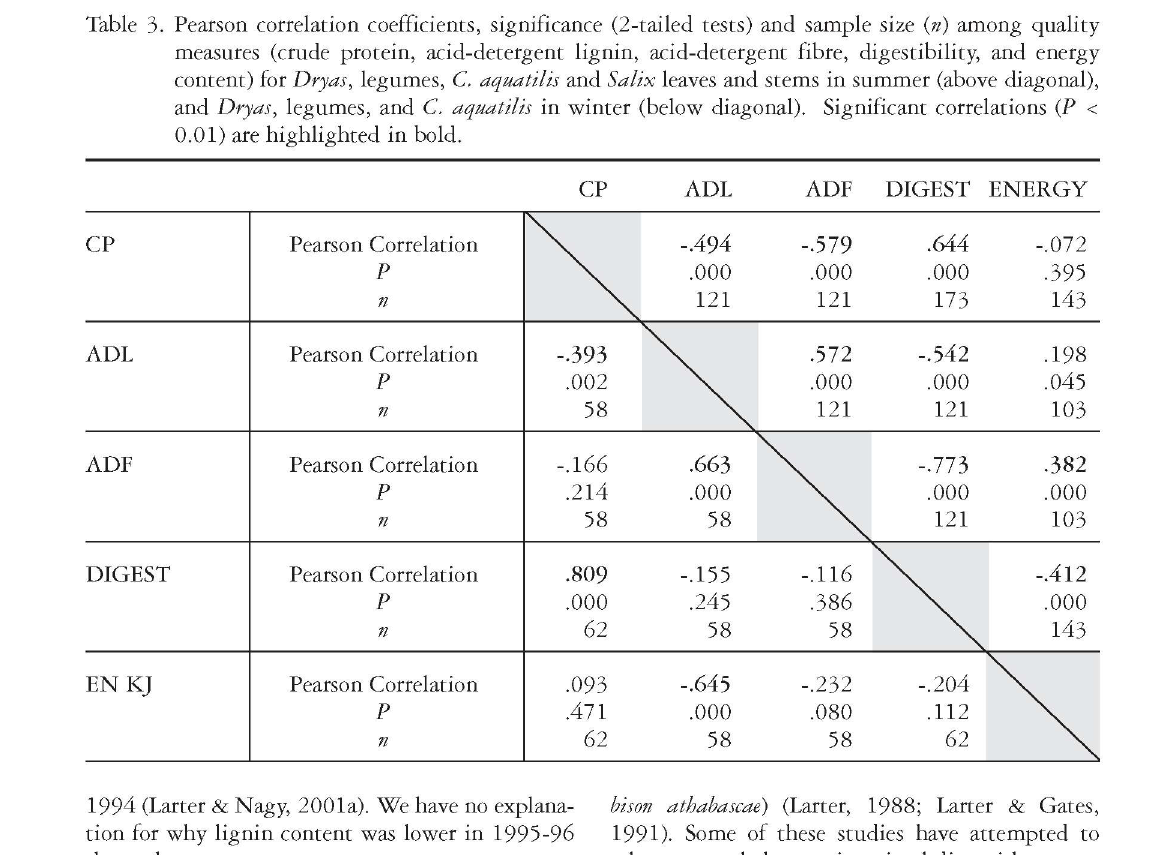
Table 3. Pearson correlation coefficients, significance (2-tailed tests) and sample size (») among quality measures (crude protein, acid-detergent lignin, acid-detergent fibre, digestibility, and energy content) for Dryas, legumes, C. aquatilis and Salix leaves and stems in summer (above diagonal), and Dryas, legumes, and C. aquatilis in winter (below diagonal). Significant correlations (P < 0.01) are highlighted in